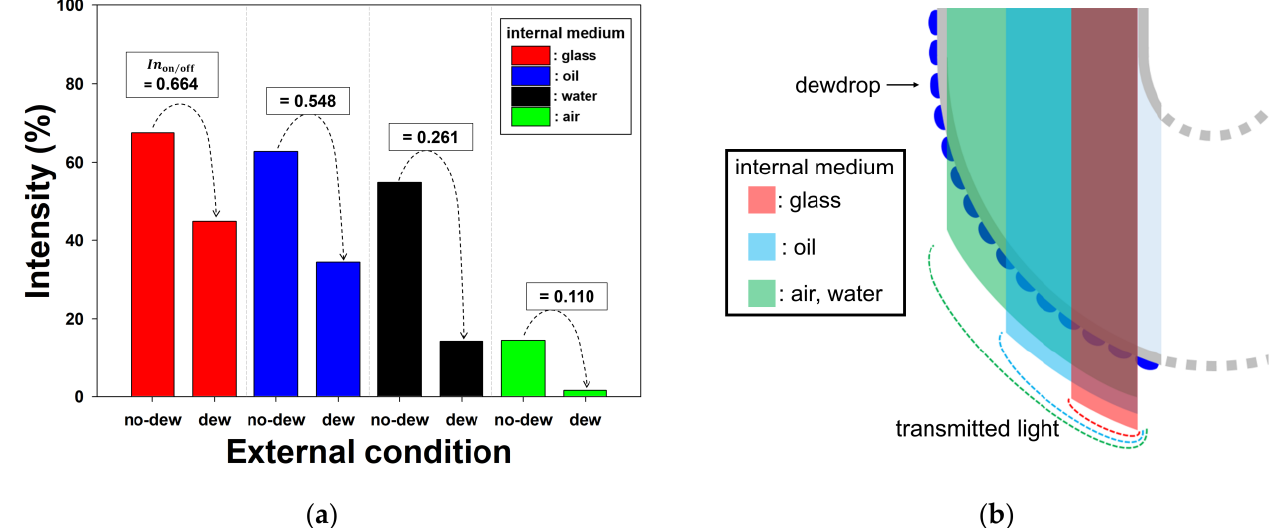
Figure 4. In the optical simulation results: ( a ) variations in the intensity according to the simulated dew condensation for the various internal media, and ( b ) the regions on the waveguide surface where the incident light rays are transmitted under conditions with dew for the various internal media.